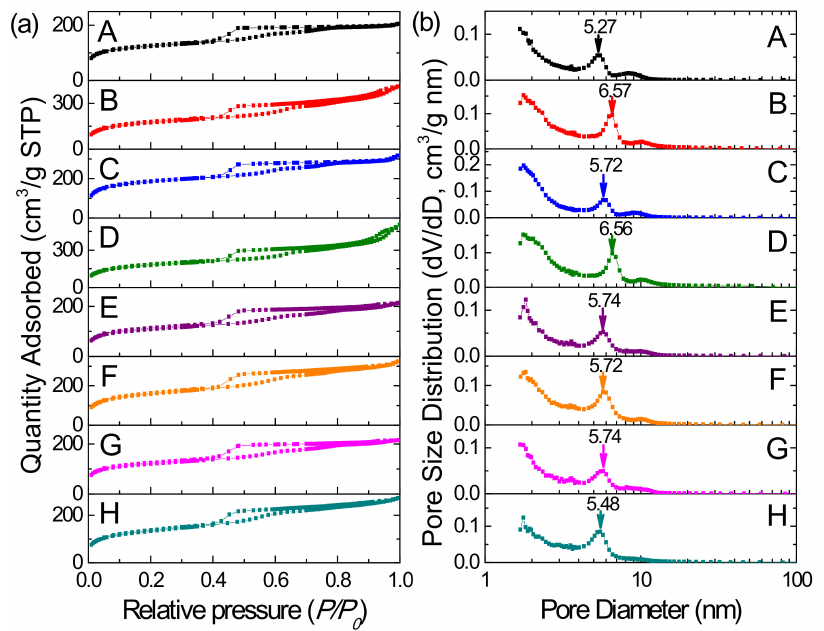
Figure 8. ( a ) Nitrogen adsorption-desorption isotherms and ( b ) pore size distribution of mesoporous organosilica samples: PMOA-1 (A), PMOA-2 (B), PMOA-3 (C), PMOA-4 (D), PMOB-1 (E), PMOB-2 (F), PMOB-3 (G), PMOB-4